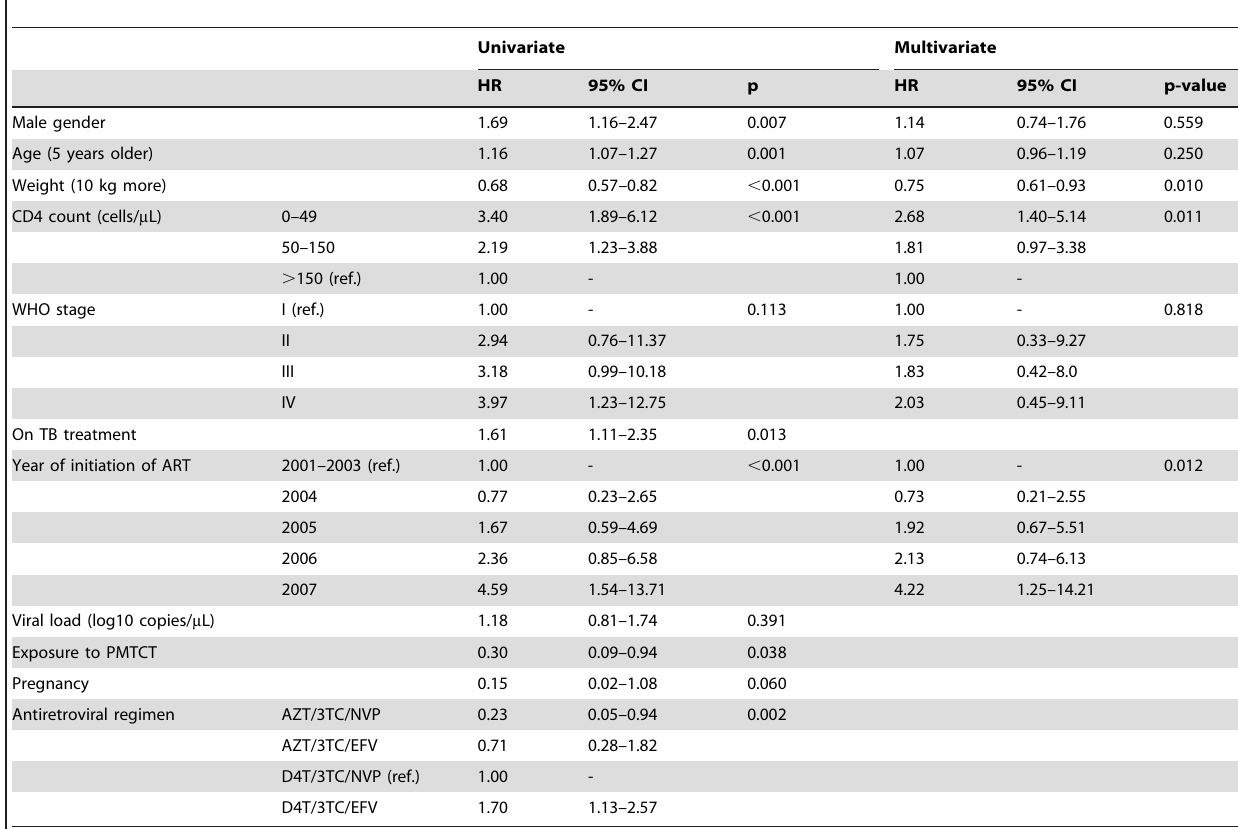
Table 3. Cox proportional hazards models of factors associated with mortality after reported loss to